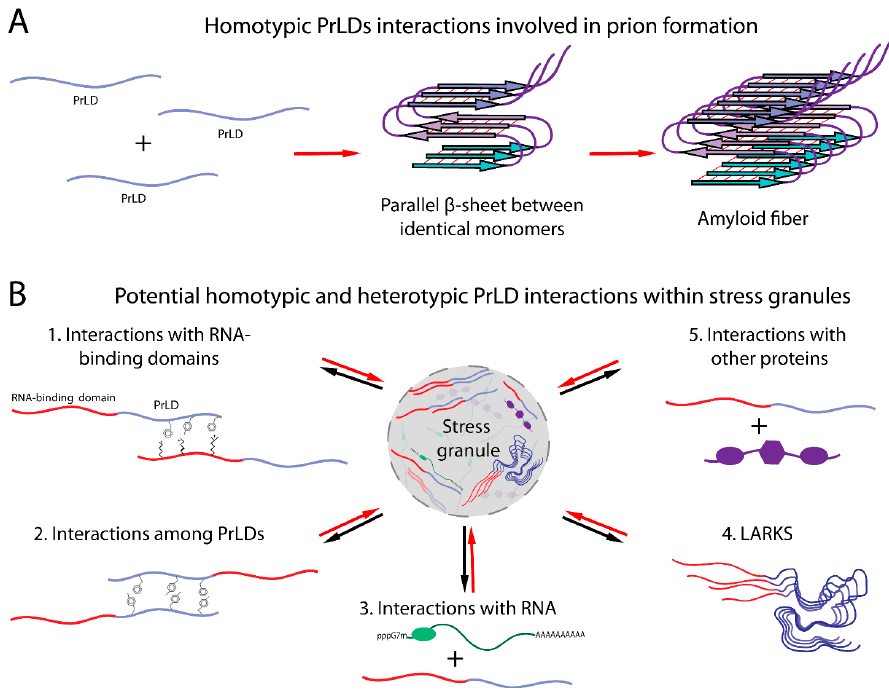
Figure 1. Potential PrLD interactions in amyloid fibers or within stress granules. ( A ) Upon prion formation, PrLDs assemble in an in-register cross- β structure involving homotypic interactions between identical monomers. ( B ) In stress granules, PrLDs have been proposed to engage in a variety of interactions, including homotypic interactions with other PrLDs, interactions with their corresponding RNA-binding domains, interactions with other stress granule proteins and RNA, and cross- β low-complexity aromatic-rich kinked segments (LARKS).